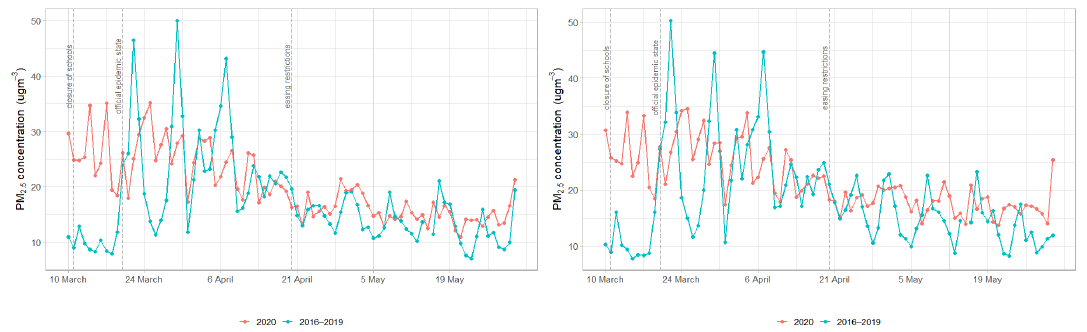
Figure 10. Average daily values of PM 2.5 concentrations at two research stations—K background (left) and W traffic (right).